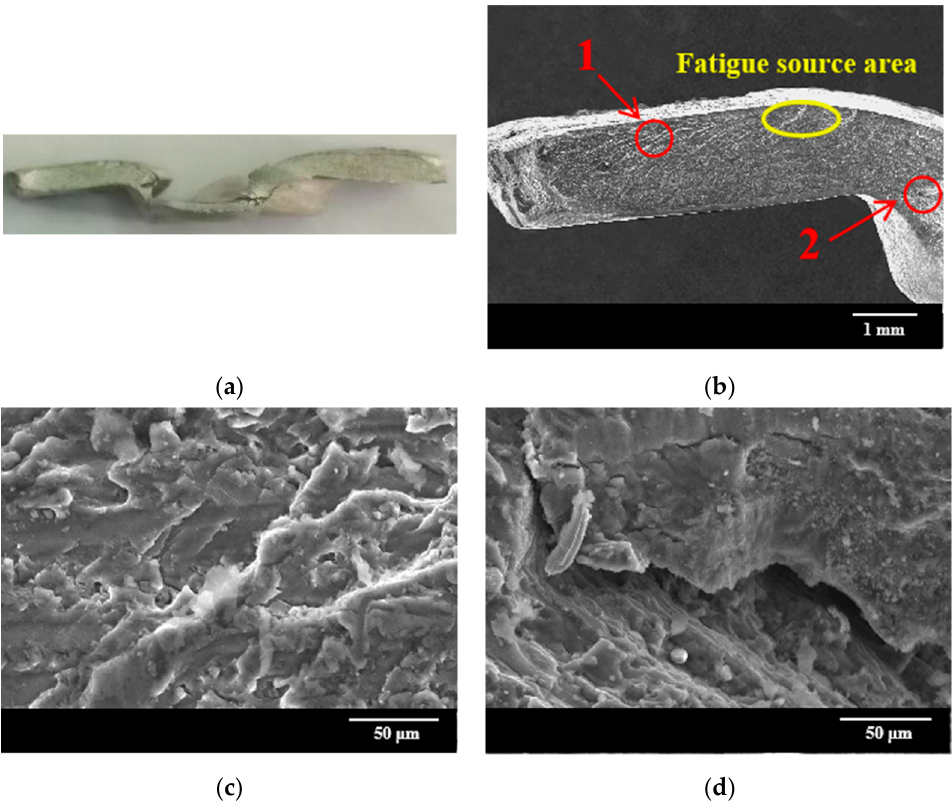
Figure 12. Fatigue fracture micromorphology of joints after 7 weeks of corrosion under 50% load: ( a ) macroscopic morphology; ( b ) microscopic morphology; ( c ) 500× magnification of area 1; ( d ) 500× magnification of area 2.